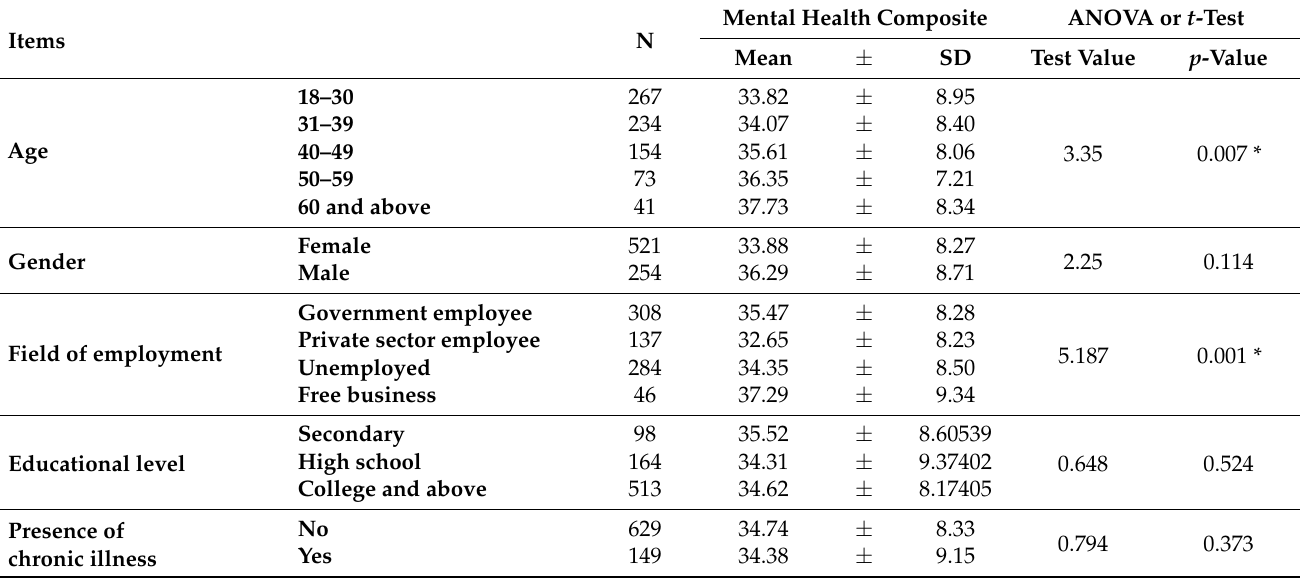
Table 5. Statistical differences between participants’ demographic characteristics and mental health (N =